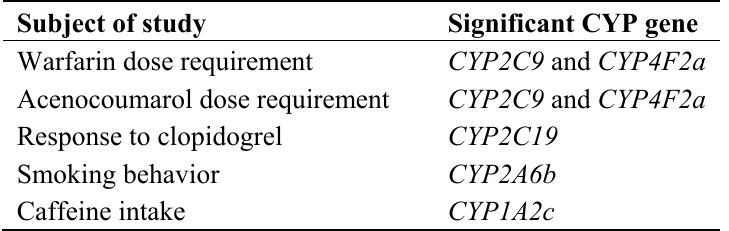
Table 1. Genome-Wide Association Studies (GWAS) Showing Significant Roles for Cytochrome P450 Genes. Reproduced with permission from Daly, A.K.